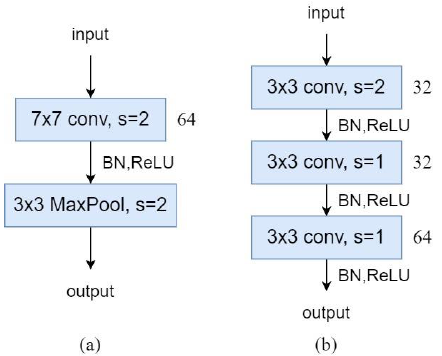
Figure 6. The stem stage of the ( a ) original ResNet and ( b ) our feature extractor.